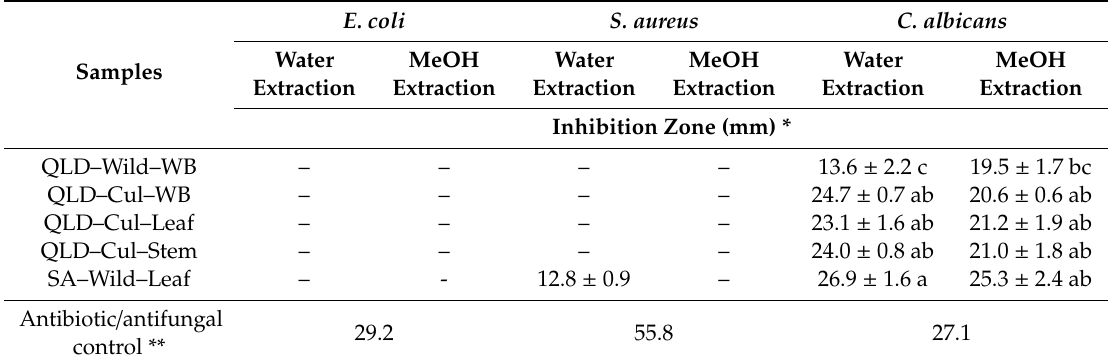
Table 5. Antimicrobial activity of the studied P. angustifolium